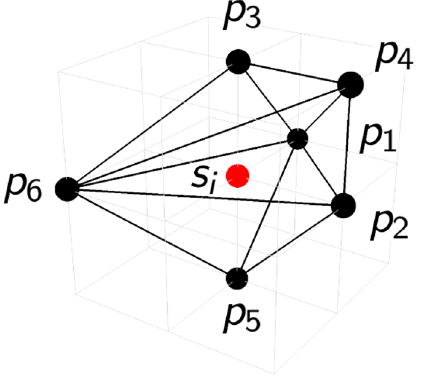
Figure 23 . Toric diagram for Model